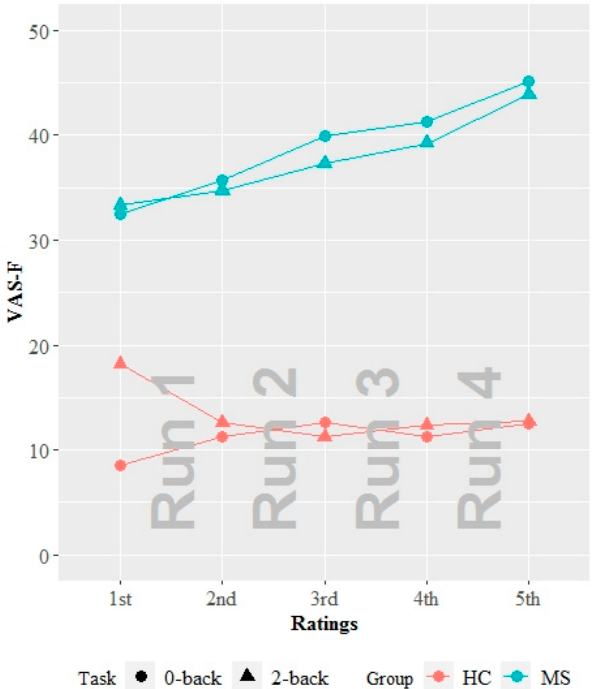
Figure 2. Differences in VAS-F scores. The VAS-F raw scores are plotted as a function of group, condition, and rating. 0-back condition is denoted by circles, and the 2-back condition is denoted by triangles. Red represents the HC group, and turquoise represents the MS group. Abbreviations: VAS-F, Visual Analogue Scale of Fatigue. MS, multiple sclerosis. HC, healthy control.